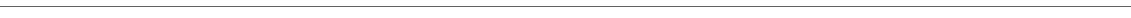
TABLE 4 | Variation in internode anatomical and biochemical variables (INLength: internode length; INDiameter: internode diameter; perSclZ1: percentage of sclerenchyma tissue (red stained) in % of Z1 area, AcBL: lignin content by acetyl bromide method in mg · g − 1 DW, ADL: Acid Detergent Lignin in %DW and SS: soluble sugars in mg · g − 1 DW) in response to studied factors: genotype G (G4 value in reference to G1), treatment T (water deficit WD value in reference to well-watered WW), and year Y (2014 value in reference to 2013). Response to